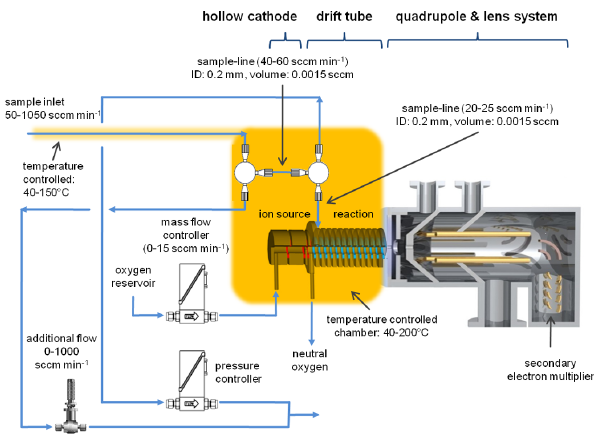
Fig. 1. Scheme of the HT-CIMS including instrumental sample in-